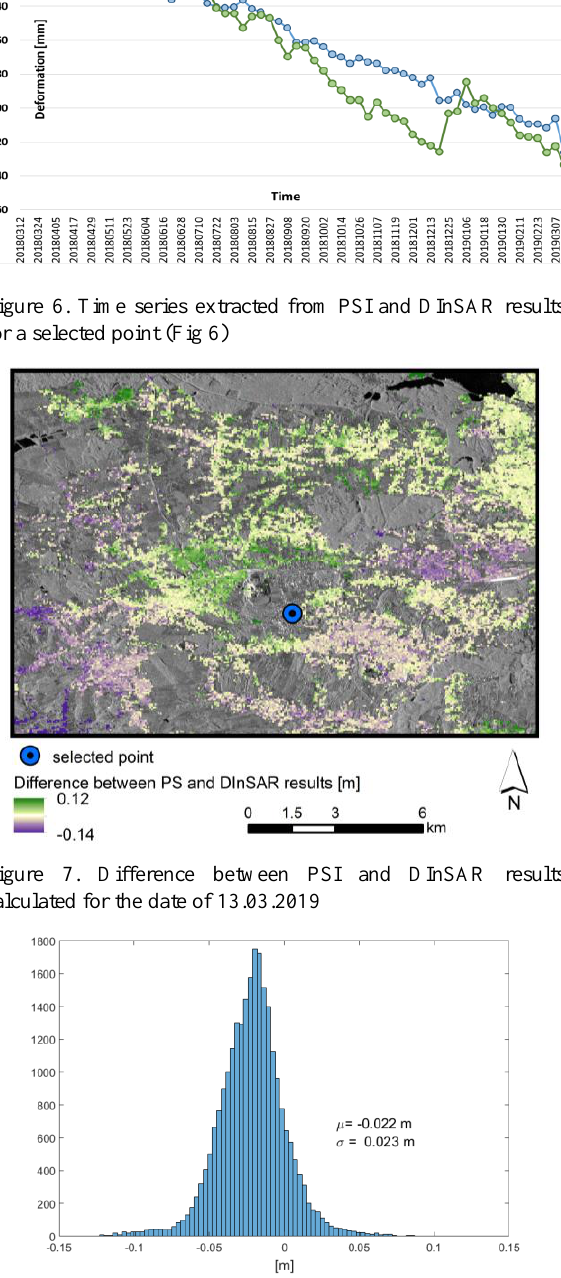
Figure 8. Histogram of the differences between PSI and